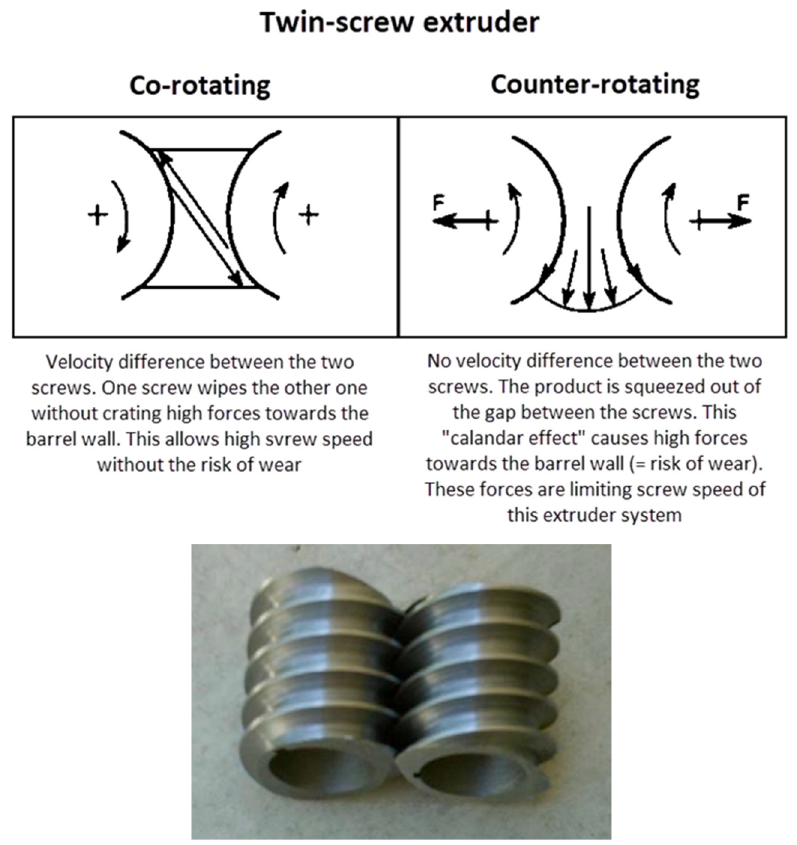
Figure 15. Wiping action in twin-screw extruders. Adapted with permission from [143].